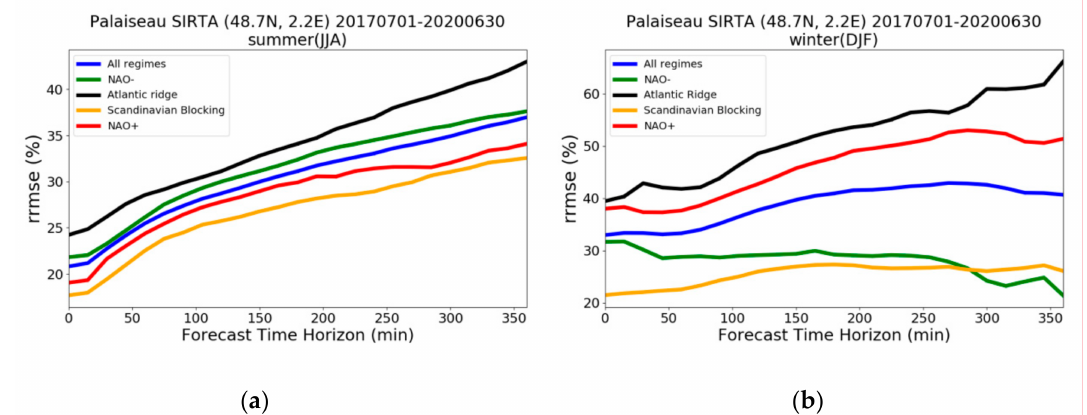
Figure 9. Relative RMSE (%) of satellite-based forecast for the di ff erent weather regimes during ( a ) summer period (JJA) and ( b ) winter period (DJF) from 1 July 2017 to 30 June 2020. In summer, the relative RMSE according to regime presents a constant ranking for all time